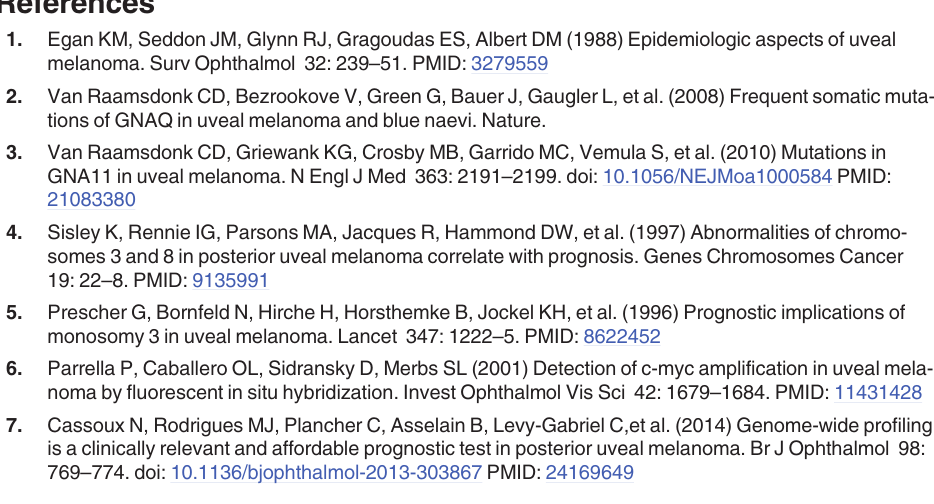
S1 Table. dPCR sequences context. S2 Table. GNAQ and GNA11 primers used for sanger sequencing. S3 Table. Hazard ratio's chromosome